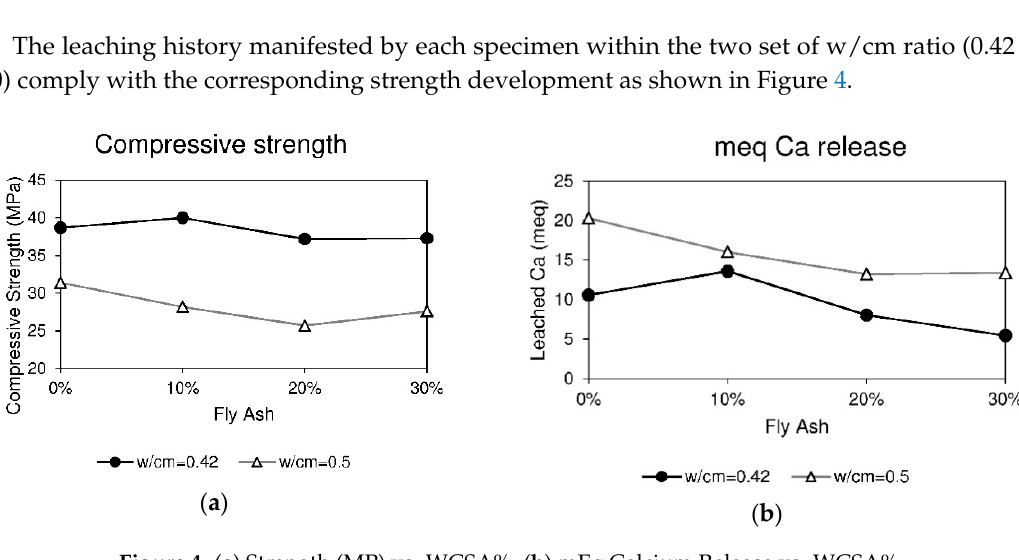
Figure 4. ( a ) Strength (MP) vs. WCSA%, ( b ) mEq Calcium Release vs.